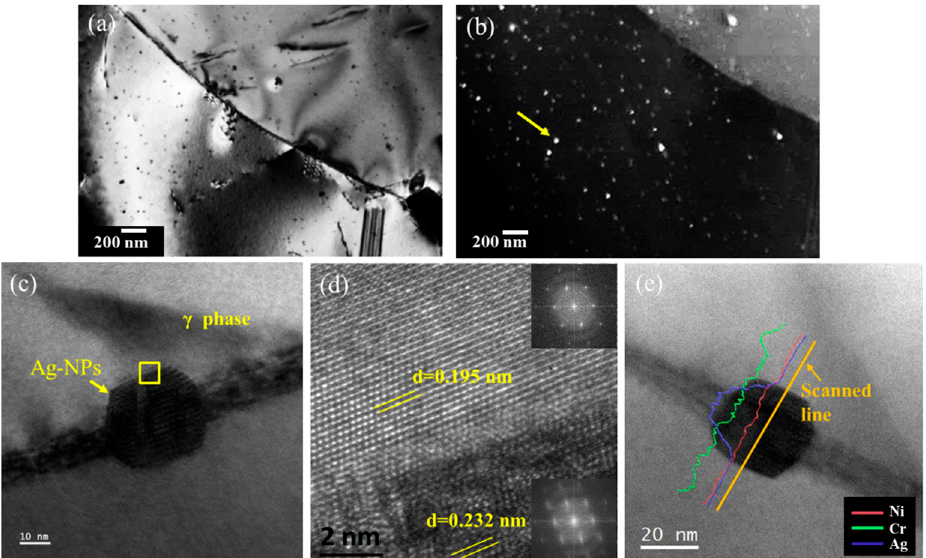
Figure 4. TEM and HR-TEM micrographs of the 2205Ag after 450 ◦ C aging treatment for 4 h. ( a ) BF image; ( b ) DF image showing some fine precipitates (indicated by yellow arrows) within austenite; ( c ) HR-TEM image of a polygonal Ag-NP; ( d ) HR-TEM image of the region marked by the yellow box in ( c ); and ( e ) results of line-scan EDS analysis for the polygonal Ag-NP, showing that the Ag-NP had high Ag content.